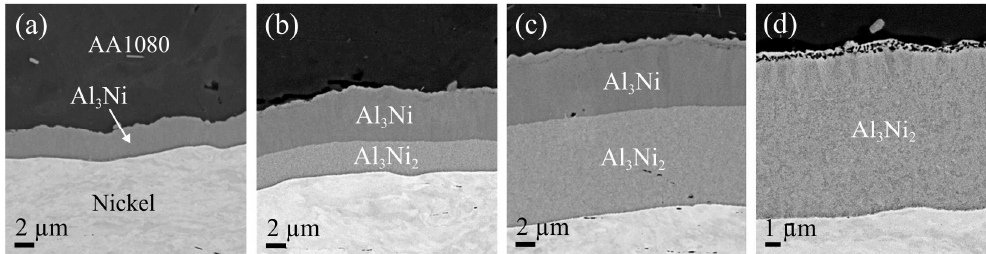
Figure 4. SEM images showing the growth of the IMP layer formed along the aluminum-nickel interface with increasing heat treatment temperature and time. ( a ) 450 °C one hour, ( b ) 500 °C one hour, ( c ) 550 °C one hour and ( d ) 550 °C two hours. Note the different scale bar in ( d ).